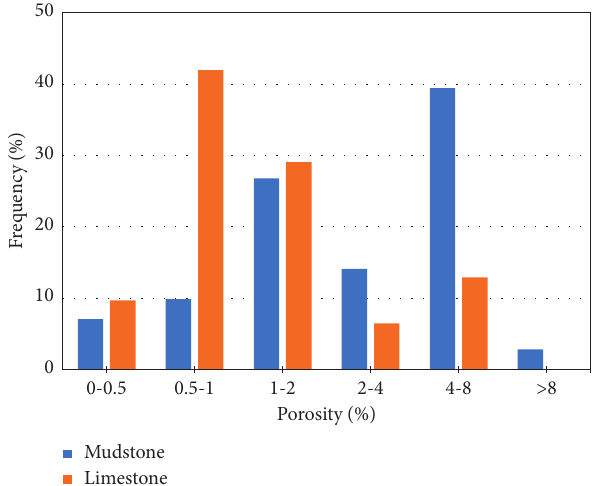
Figure 5: Porosity frequency histogram of two lithological structures in Da’anzhai Member of the Sichuan Basin.